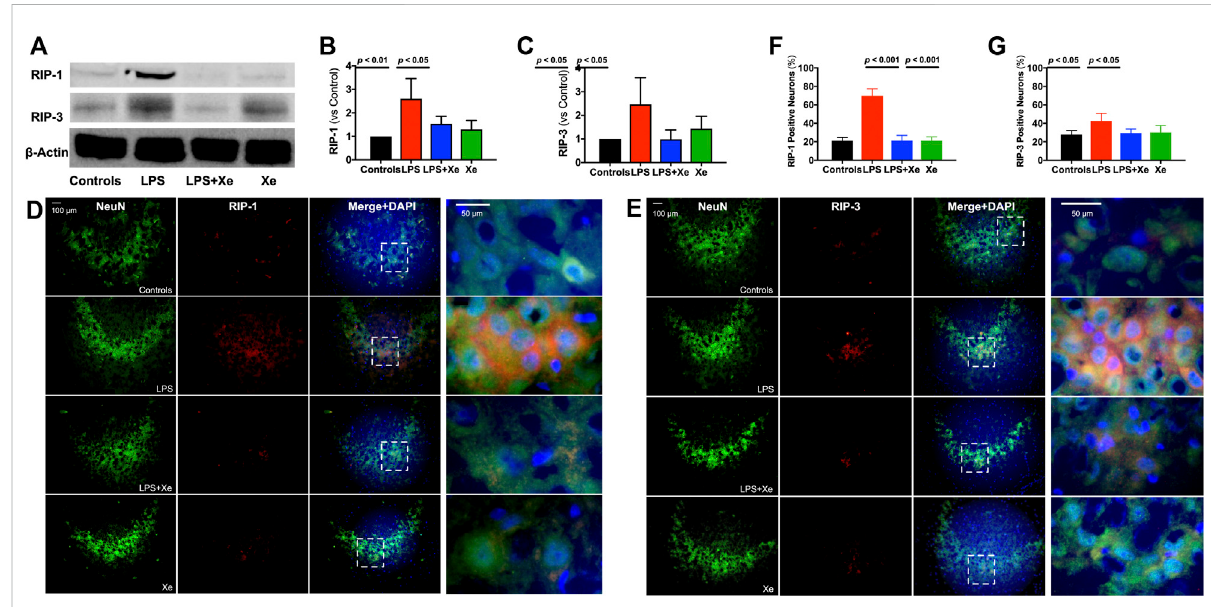
FIGURE 3 Xenon prevented persistent activation of necroptosis in juvenile rats with neonatal LPS administration. Representative western blot bands (A) with quanti fi cation (B,C) for necroptosis in PND 30 animals (27 days after initial LPS injection). Representative immunohistochemistry staining (D,E) withquanti fi cation (F,G) indictingpersistentneuronalnecroptosisinPND30animals.Dataareexpressedasmean±SD.(Con=salineinjection+70% N 2 /30%O 2 ;LPS=LPSinjection+70%N 2 /30%O 2 ;LPS+Xe=LPSinhalation+70%Xenon/30%O 2 ;Xe=salineinjection+70%Xe/30%O 2 ; n =4in each group except n = 3 in group LPS for western blotting).